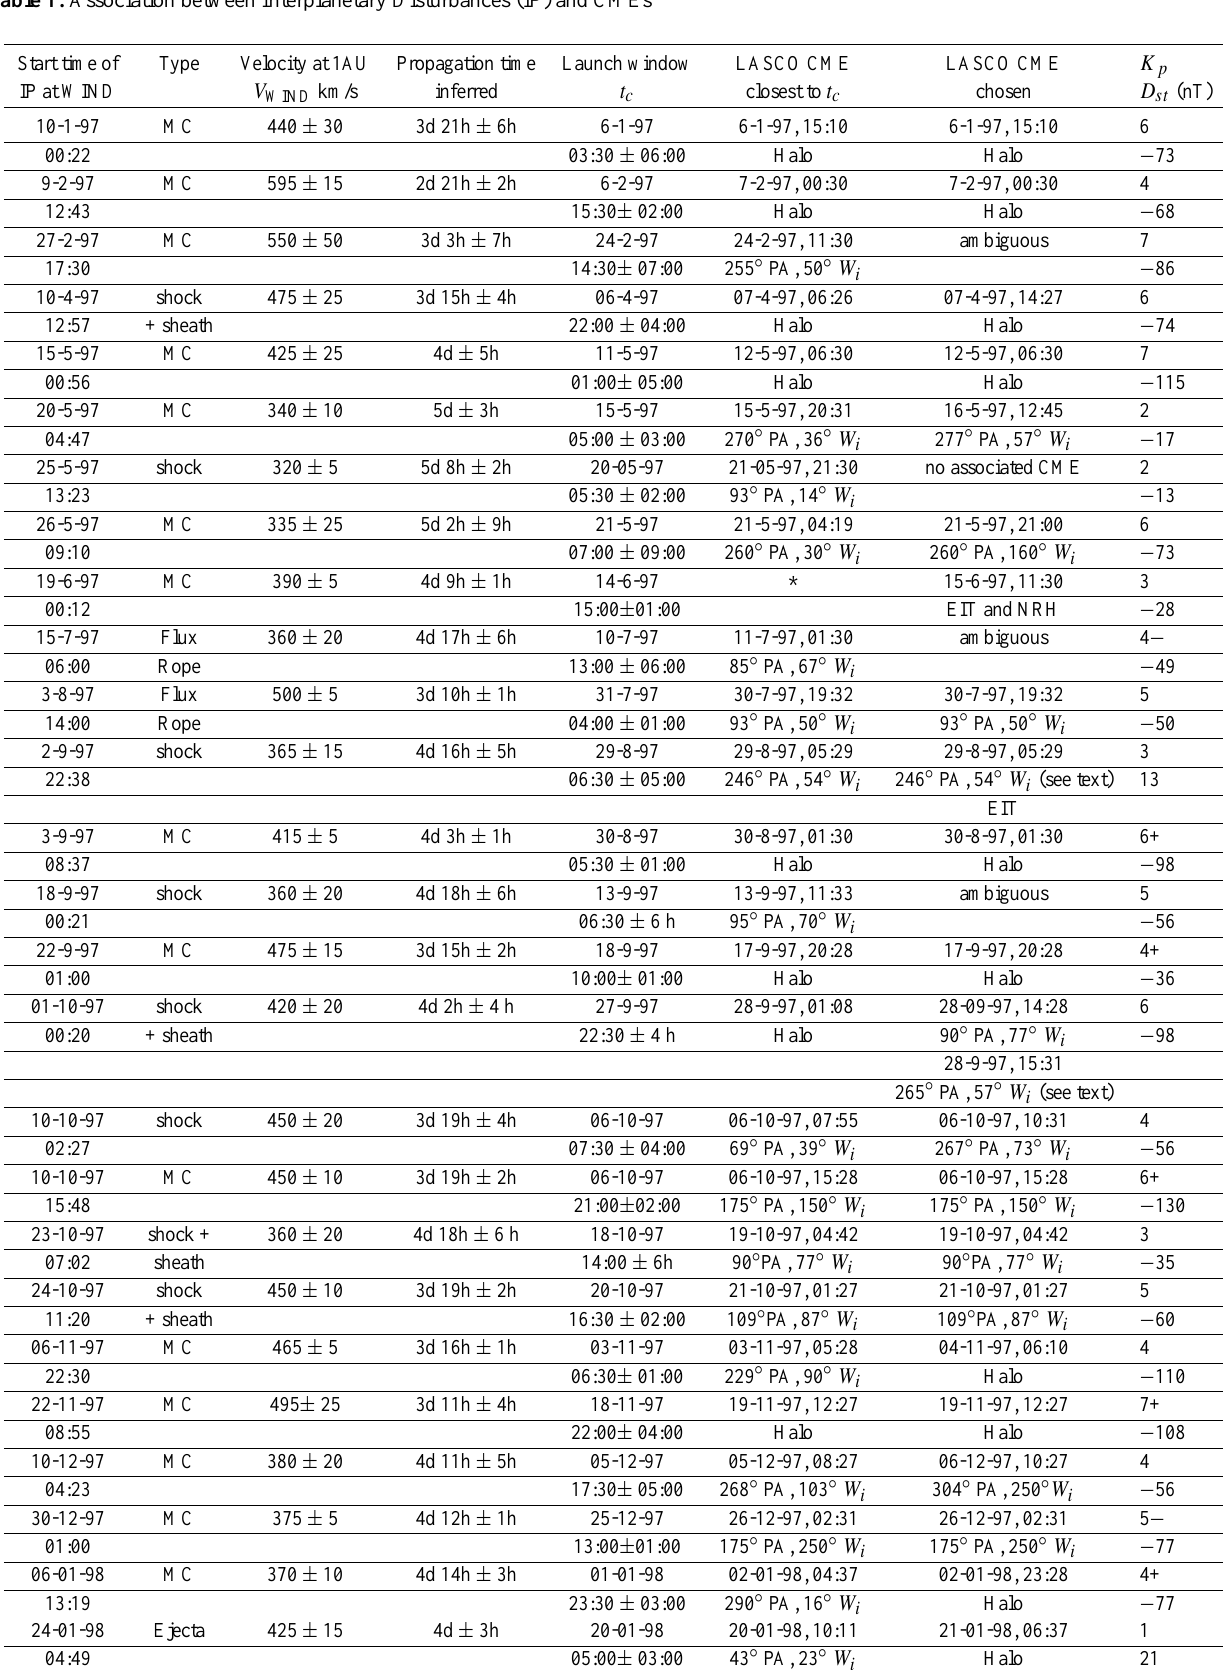
Table 1. Association between Interplanetary Disturbances (IP) and